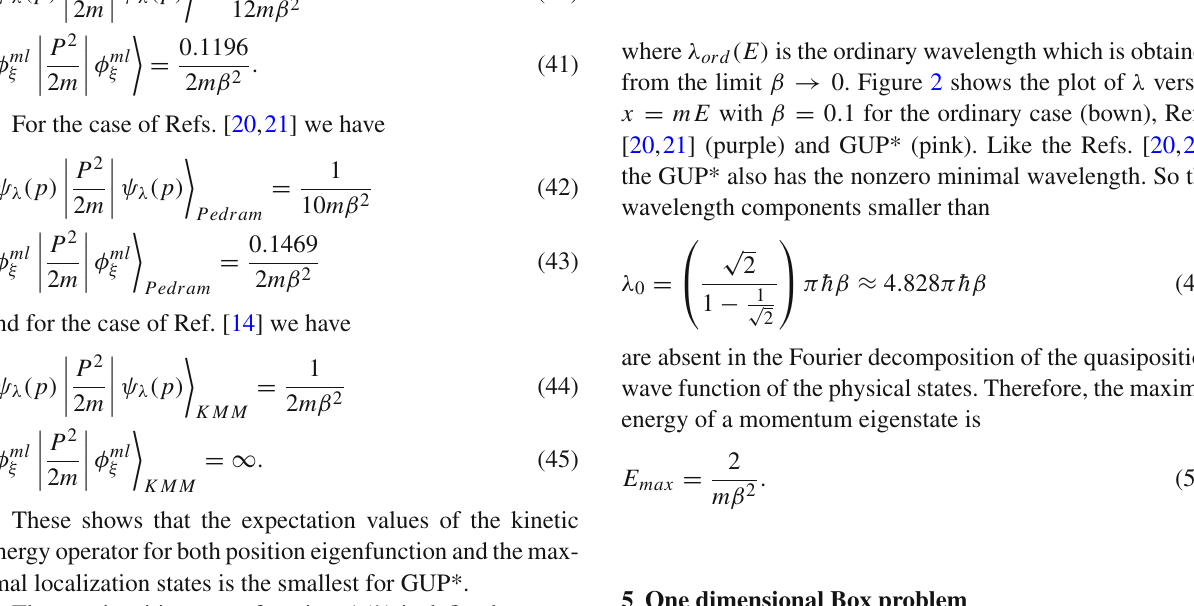
Fig. 2 Plot of λ versus x = mE with β = 0 . 1 for the ordinary case (brown), Refs. [20,21] (purple) and GUP* (pink)